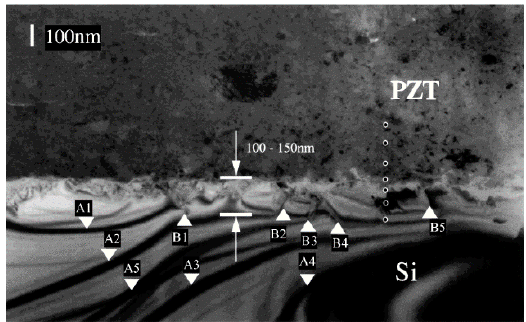
Figure 5. Typical transmission electron microscopy (TEM) image (cross-sectional) of a lead zirconate titanate (PZT) thick film deposited on Si substrate at room temperature (RT) via AD [11]. © Copyright 1999, Jpn. J. Appl. Phys.